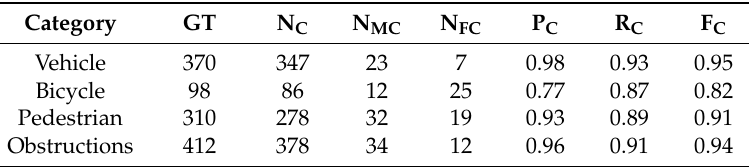
Table 7. Experimental evaluation of the obstacle classification module.